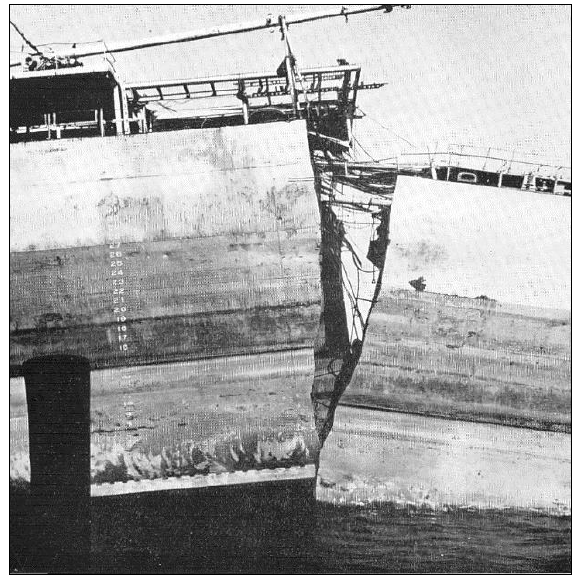
Figure 1. Liberty Ship Schenectady in the port of Portland fractured from deck to keel. Reproduced with permission from [3], Springer, 2009.